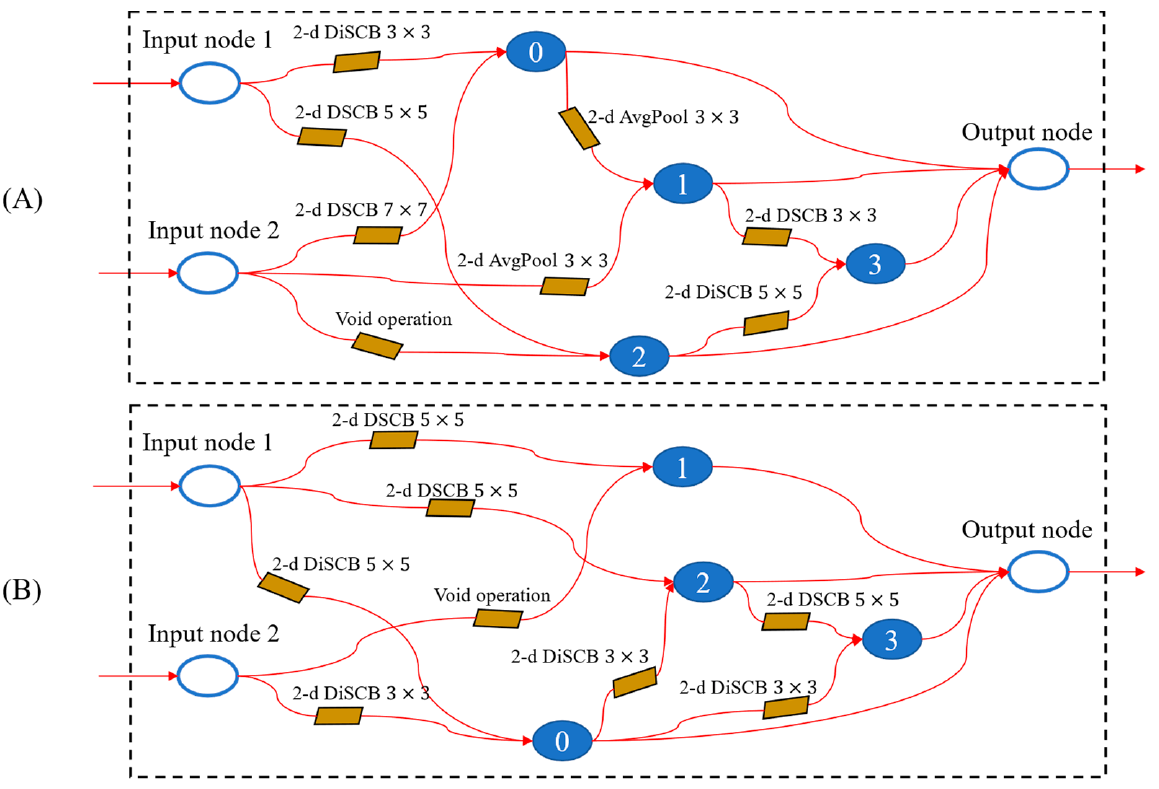
Figure 10. ( A ) Normal cell architecture obtained from CAS; ( B ) reduction cell architecture obtained from CAS. (the transparent circles represent the input/output nodes, the normal circles represent the intermedia nodes, the arrows means the links between nodes and number 0-3 means the order of the intermedia nodes).